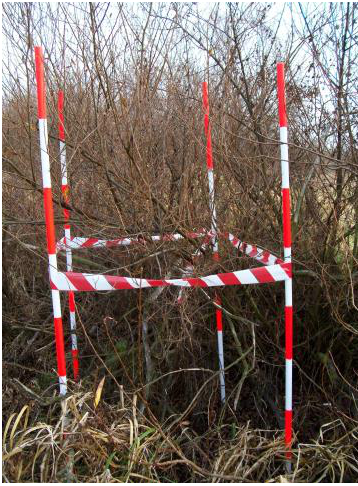
Figure 1. Place for measuring diameters and spacing.